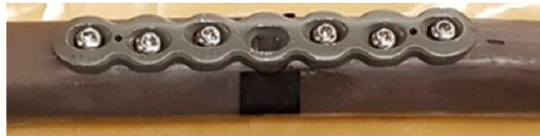
Figure 2. Close up view of the plate-screw fixation.